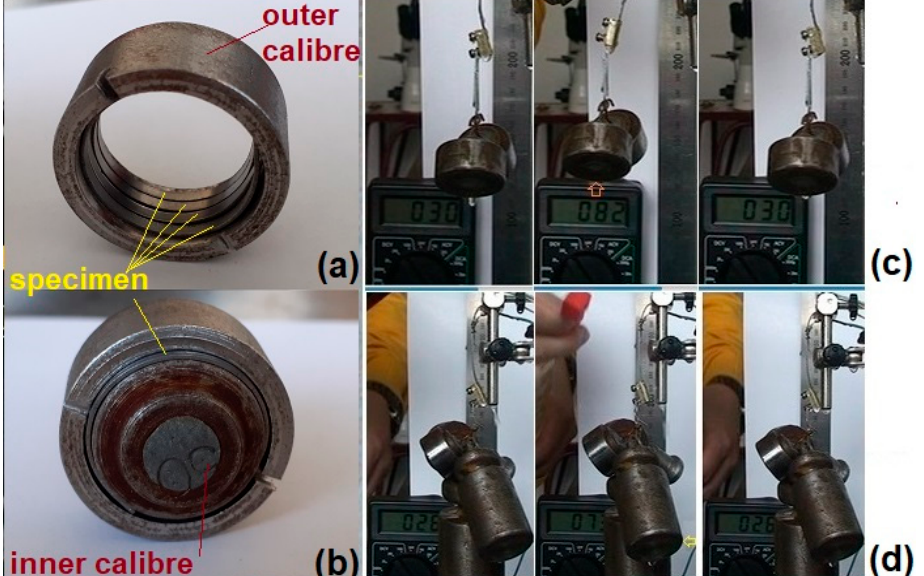
Figure 1. Experimental training procedures based on: ( a ) FR-SME with the outer caliber cold shape setting; ( b ) FR-SME with the outer and inner caliber cold shape setting; ( c ) WG-SME under a 170 g applied load; ( d ) WG-SME under a 950 g applied load.